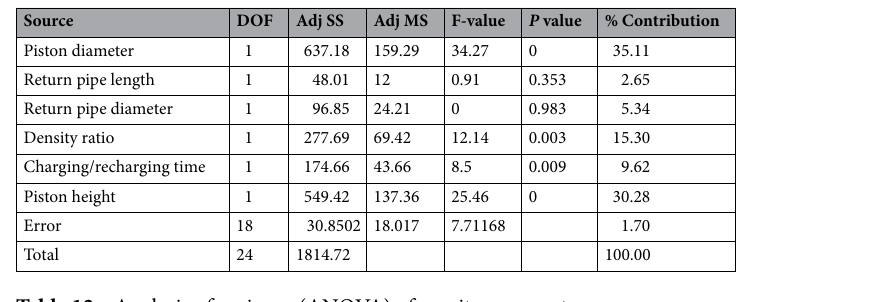
Table 12. Analysis of variance (ANOVA) of gravity energy